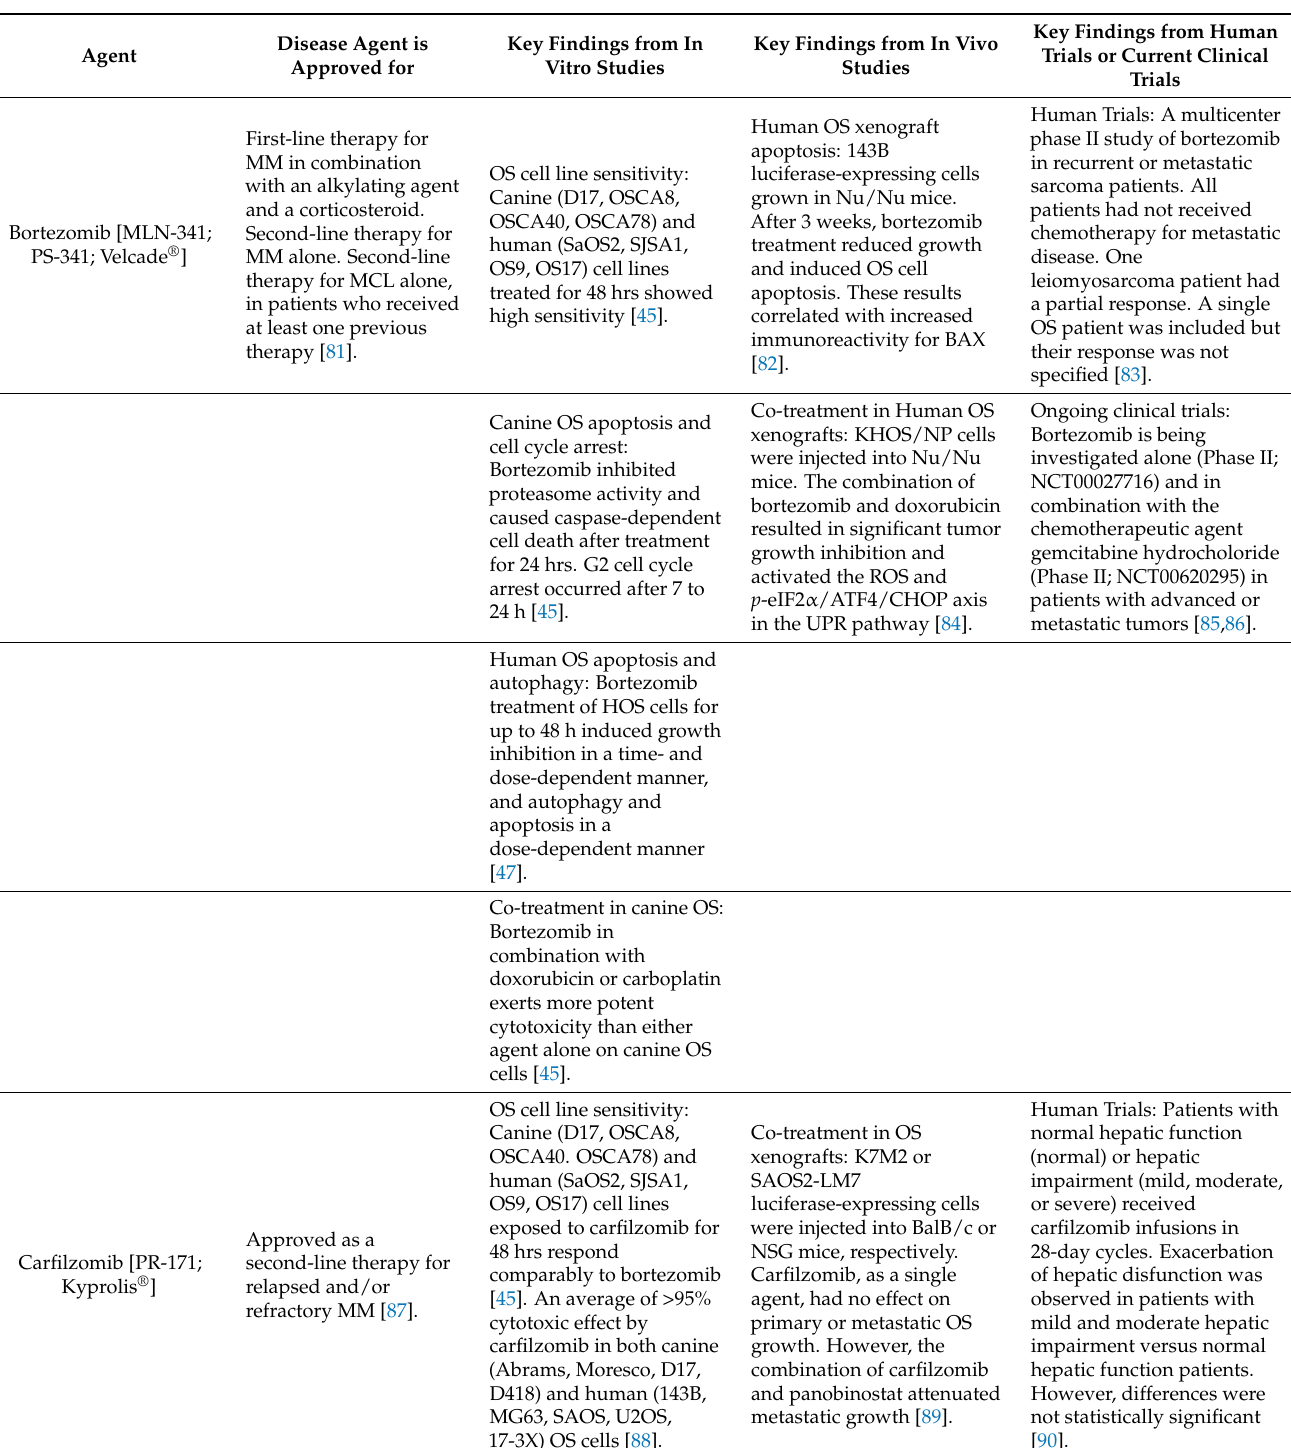
Table 1. Key findings from preclinical and clinical research that has explored FDA-approved PIs in both human and canine